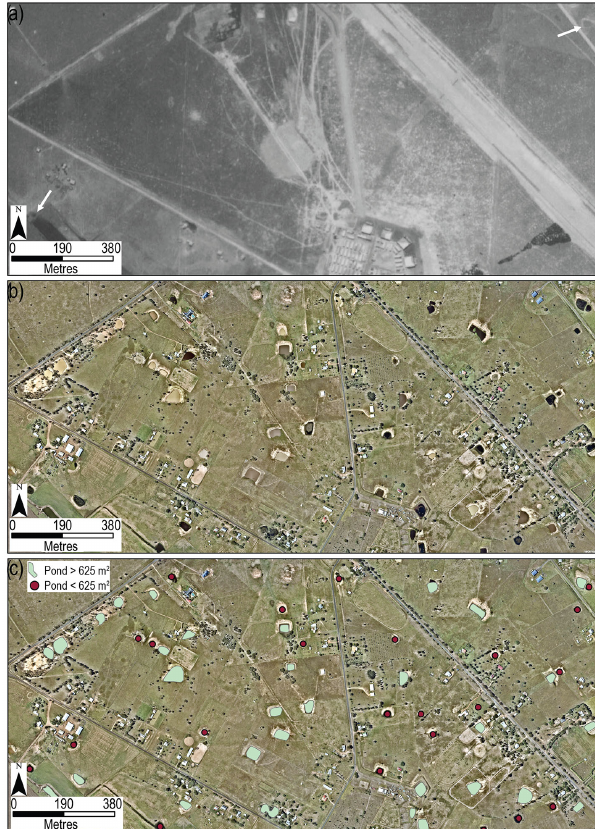
Figure A1. Historical changes in pond distribution from a 2.7km 2 area in south-east Queensland, Mt Tarampa (27 ◦ 27 (cid:48) 44 (cid:48)(cid:48) S, 152 ◦ 28 (cid:48) 59 (cid:48)(cid:48) E). (a) 1944 aerial images showing 2 ponds indicated by white arrows, (b) 2017 aerial image showing 54 ponds and (c) showing the relative distribution of ponds from the Reser- voir (>625m 2 ) database and the Water Storage Point (<625m 2 ) database – together this results in a density of 20 pondskm − 2 .